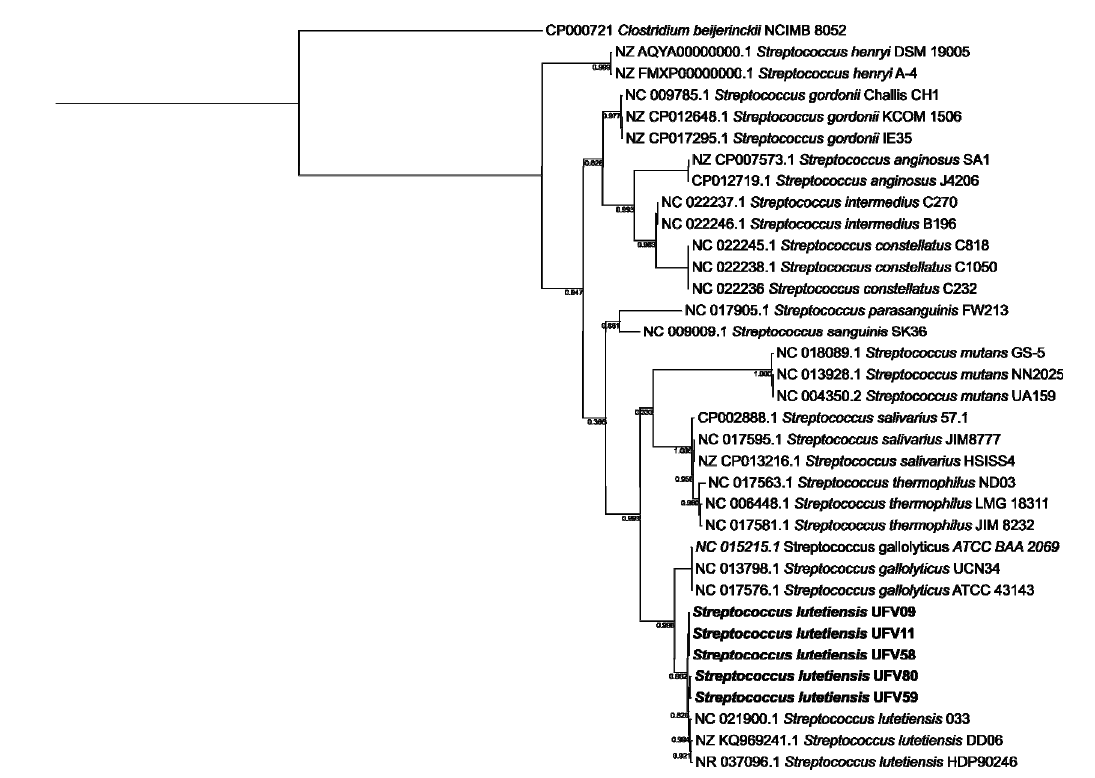
Figure 1. Phylogenetic tree based on 16S rRNA gene sequences from ruminal streptococci isolated from Nelore steers and other Streptococcus spp. The 16S rRNA gene sequences were aligned by RDP Aligner release 11 and the tree was reconstructed using the Maximum Likelihood method with FastTree v2.1 (1000 replicates) and visualized and annotated in the iTOL platform. The bootstrap values are shown near resolved branches. The scale bar represents 0.01 nucleotide substitutions per nucleotide position.